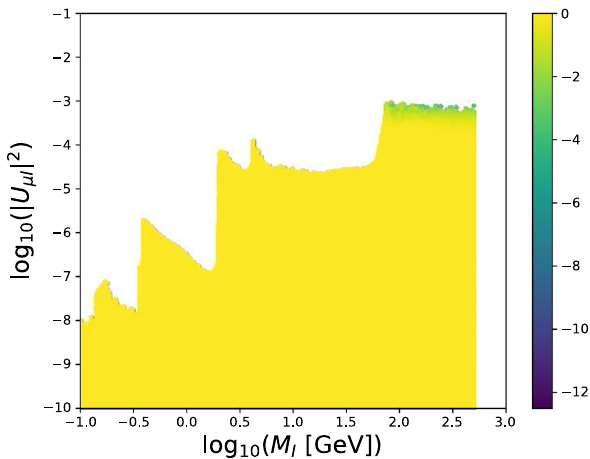
Fig. 35 Partial likelihood from the lepton flavour violating μ − e con-